Question: Does the figure show an increasing or a decreasing trend?
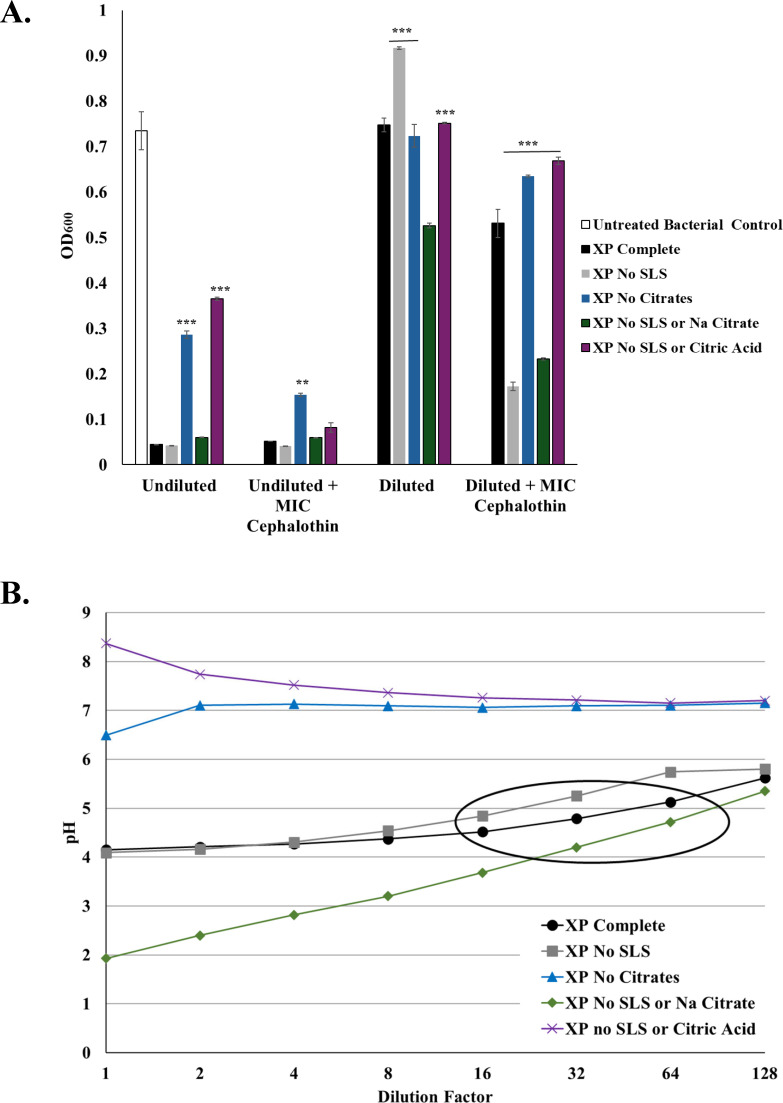
Answer: increasing